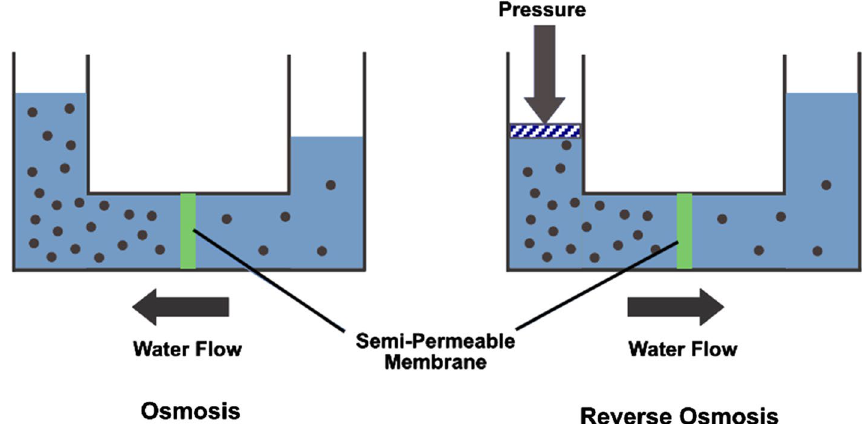
Fig. 9 Schematics of osmosis and reverse osmosis process (Widiasa et al.